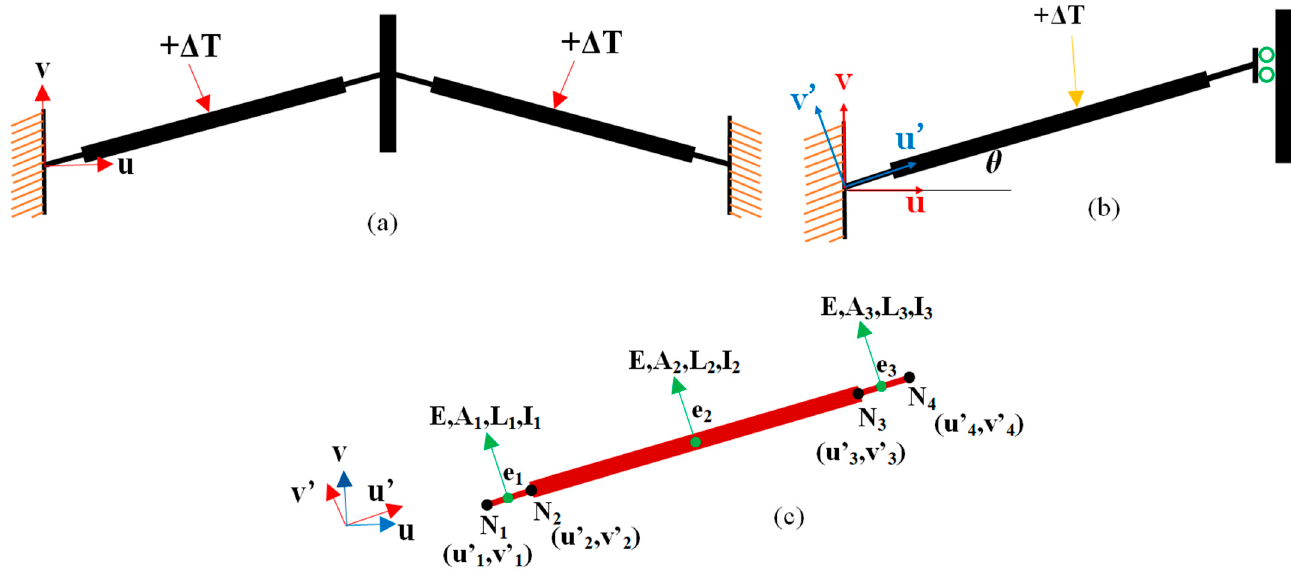
Figure 3. ( a ) Schematic of a pair of stepped inclined beams subjected to an average increase in temperature ( ∆ T ) . Each beam has a thicker and longer element in the center, and two thinner and shorter beams at the ends; ( b ) equivalent mechanical representation of a single beam in a local reference frame; ( c ) single inclined beam of the thermal actuator modeled by four nodes and three elements. Elements 1 and 3 correspond to the short beams that connect the central beam (element 2) to the anchor (left end) and shuttle (right end), respectively